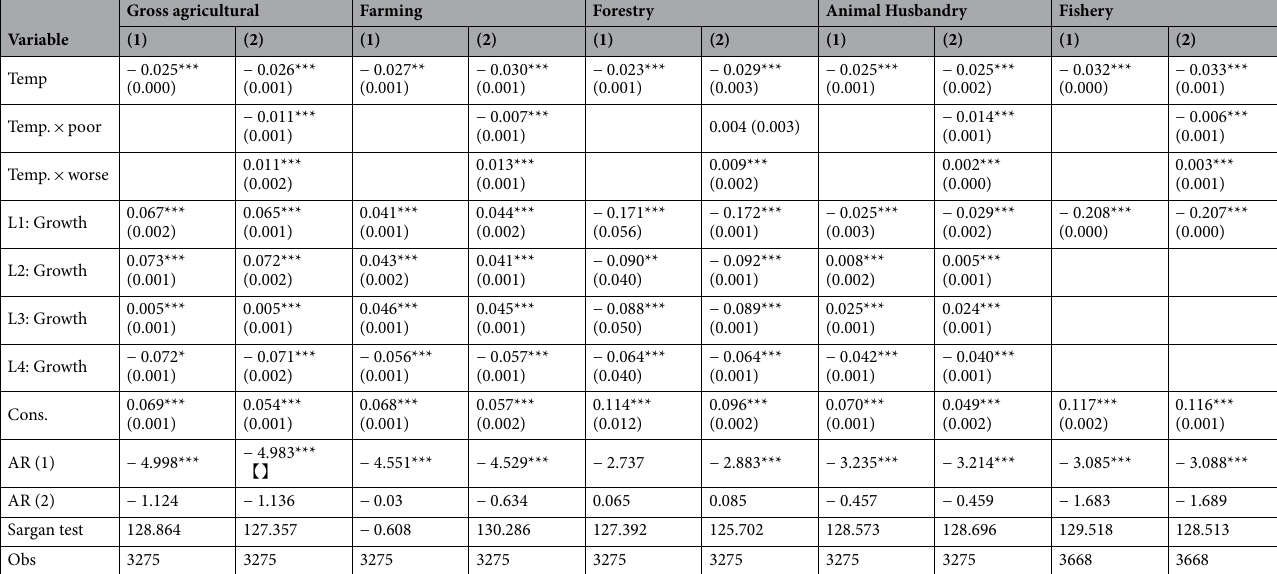
Table 6. Estimated effects of changes in average temperature during the farming period on agricultural growth. (1) The values in parentheses are robust standard errors. (2) ***, **, * indicate significant at the statistical level of 1%, 5%, and 10%, respectively.